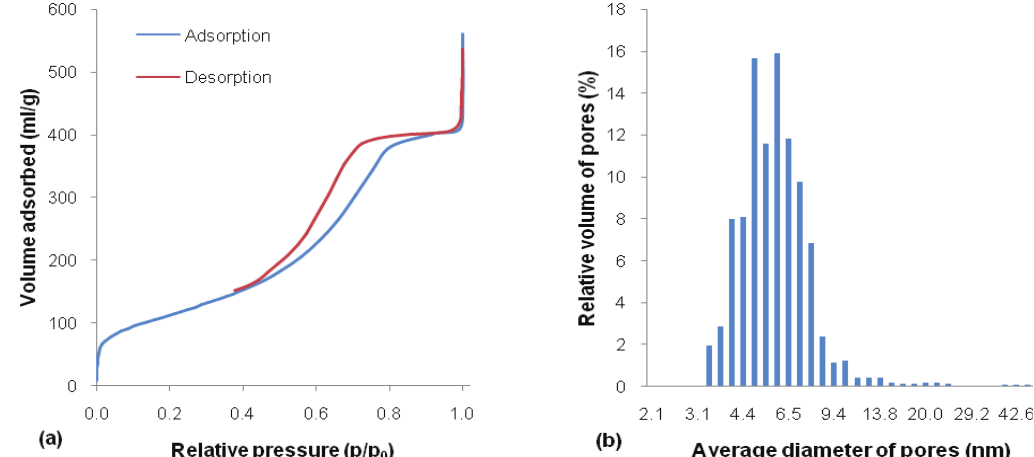
Figure 1. (a) Nitrogen adsorption/desorption isotherms at 77 K; (b) Pore size distribution of H